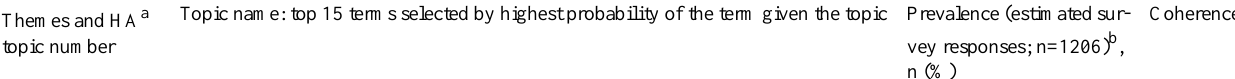
CoherencePrevalence (estimated sur- vey responses; n=1206) b ,